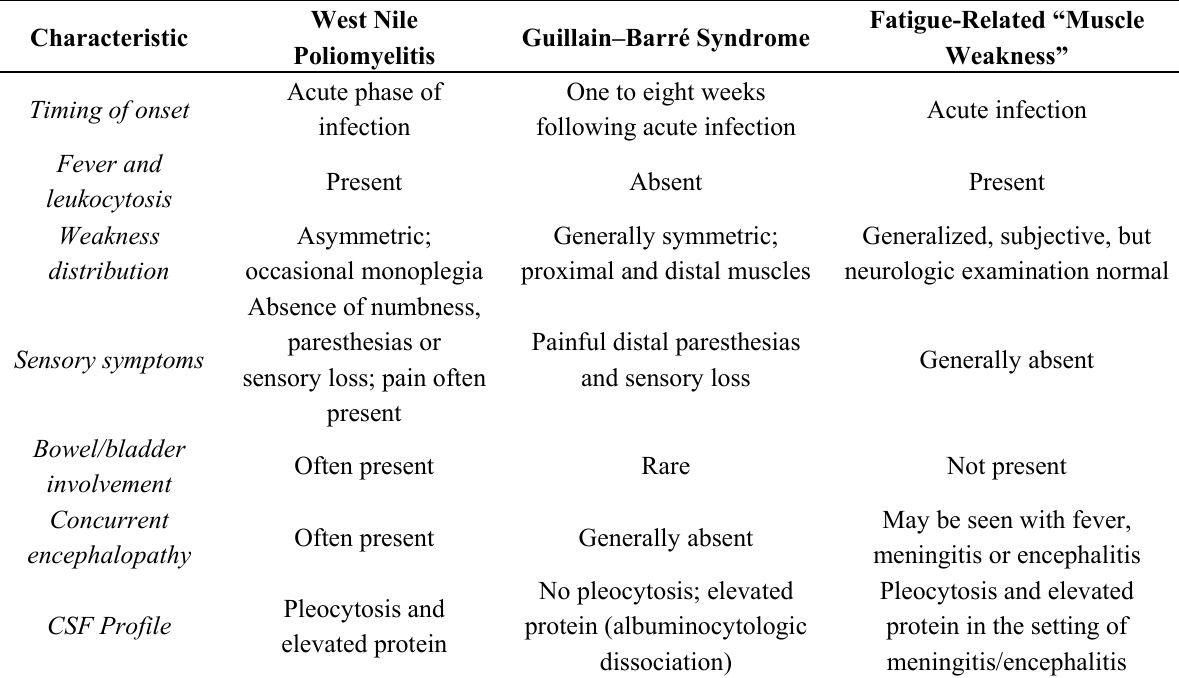
Table 1. Clinical and electrodiagnostic features of different types of weakness associated with West Nile virus